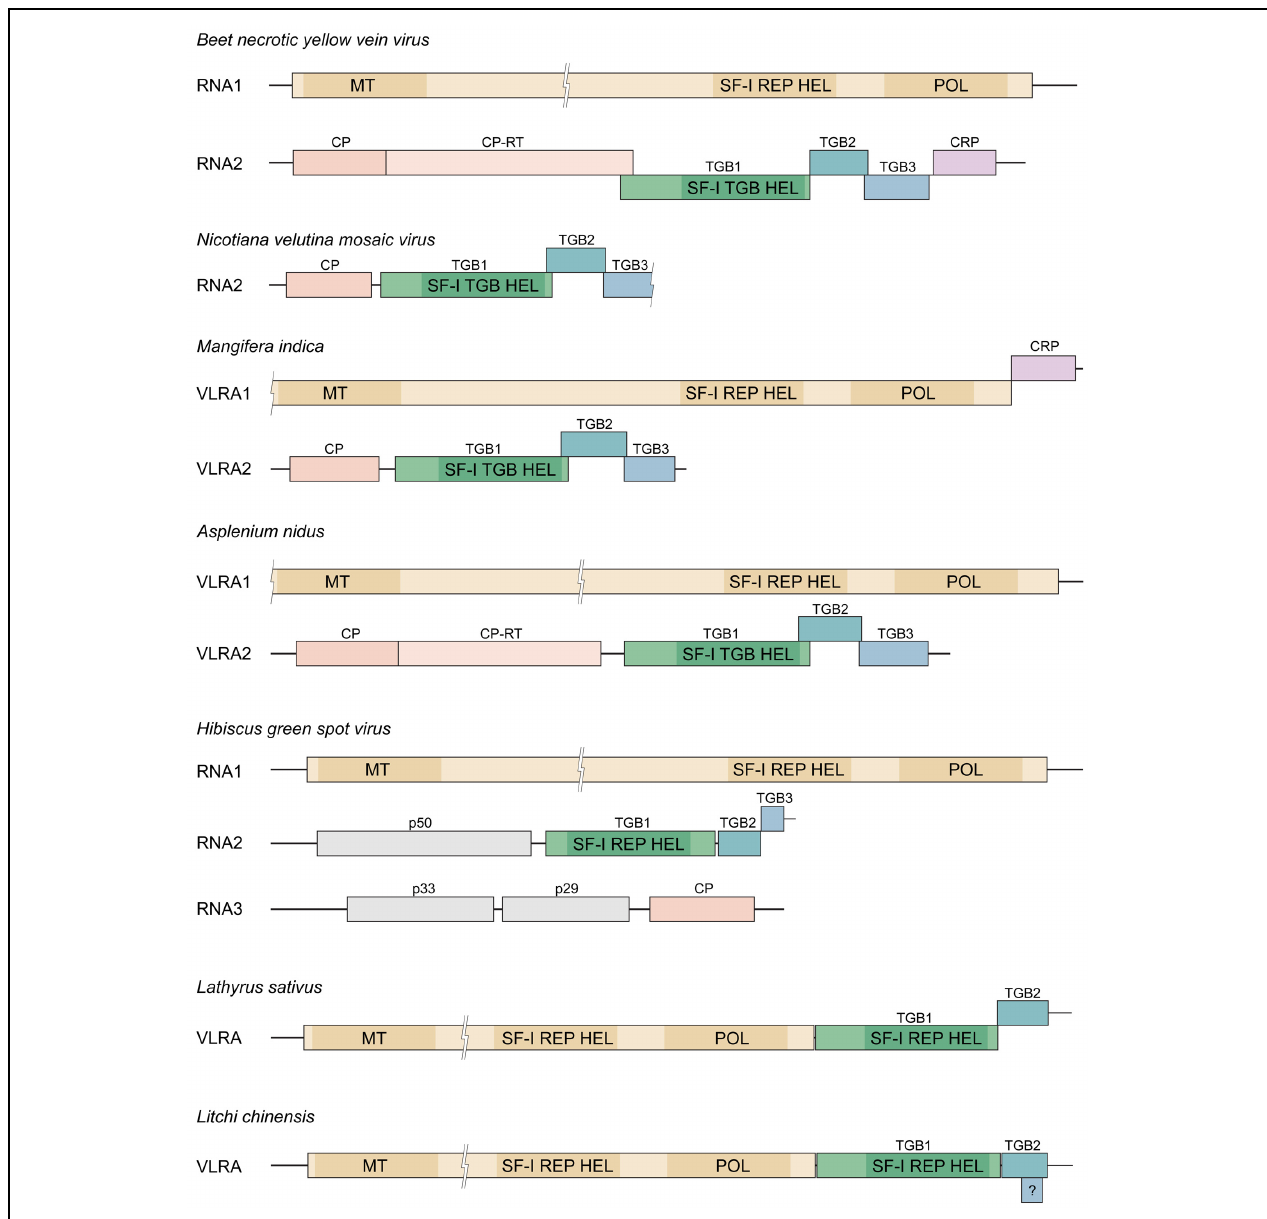
FIGURE 1 | Triple gene block (TGB) in genomes of different plant viruses and virus-like RNA assemblies (VLRAs). Genes are shown as boxes, and molecular masses of the encoded proteins with unknown function are indicated. TGB is shown in green. Genes of replicative proteins are shown in yellow. The locations of conserved protein sequence domains of methyltransferase (MT), helicase (HEL) and polymerase (POL) are indicated by shading. Other domains